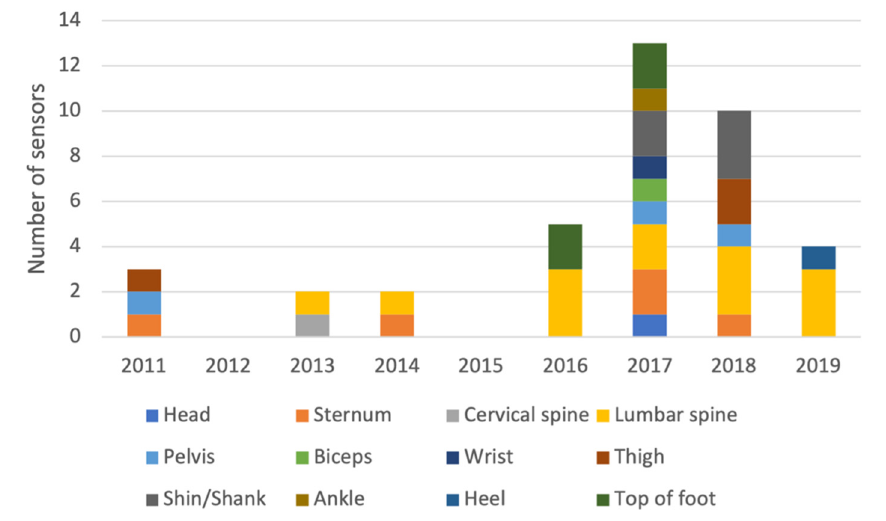
Figure A2. Number of sensors per body location for articles in Table 4, per publication year.